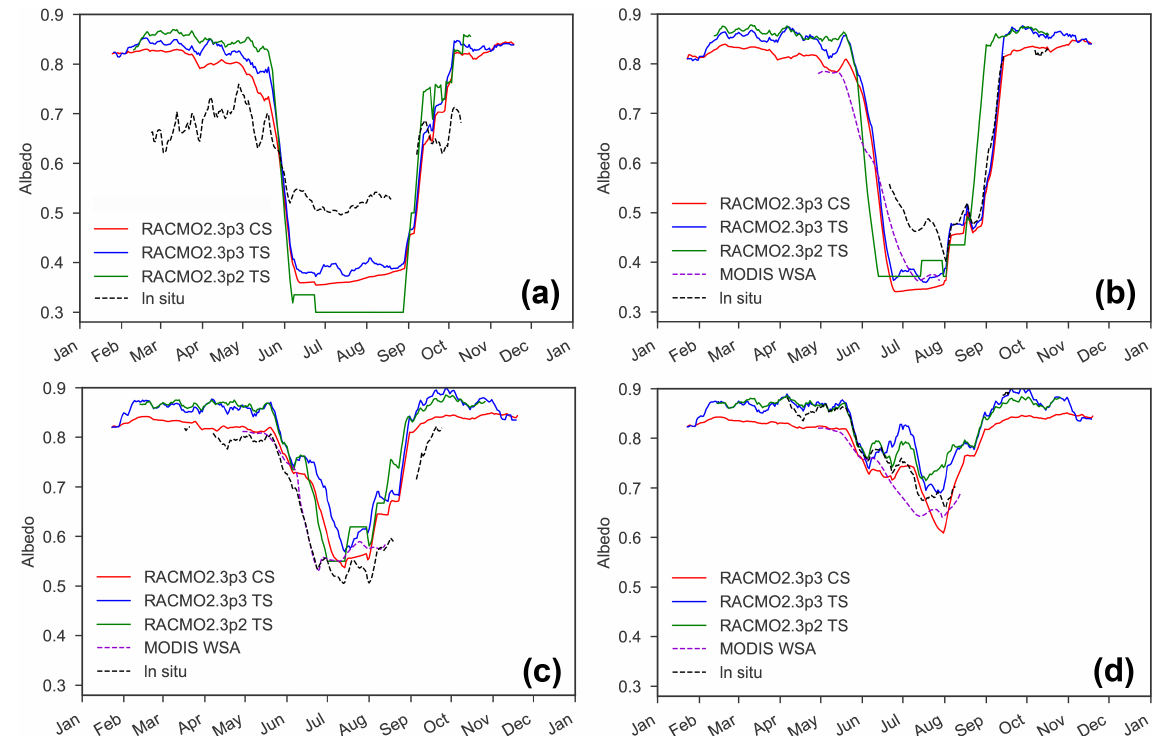
Figure 5. Time series of the average 16d running mean broadband albedo for 15:00UTC for RACMO2.3p3 clear-sky (CS) and total-sky (TS) conditions, RACMO2.3p2 TS, MODIS clear-sky diffuse (CSD) albedo and in situ albedo for 2012 for (a) S5, (b) S6, (c) S9 and (d)